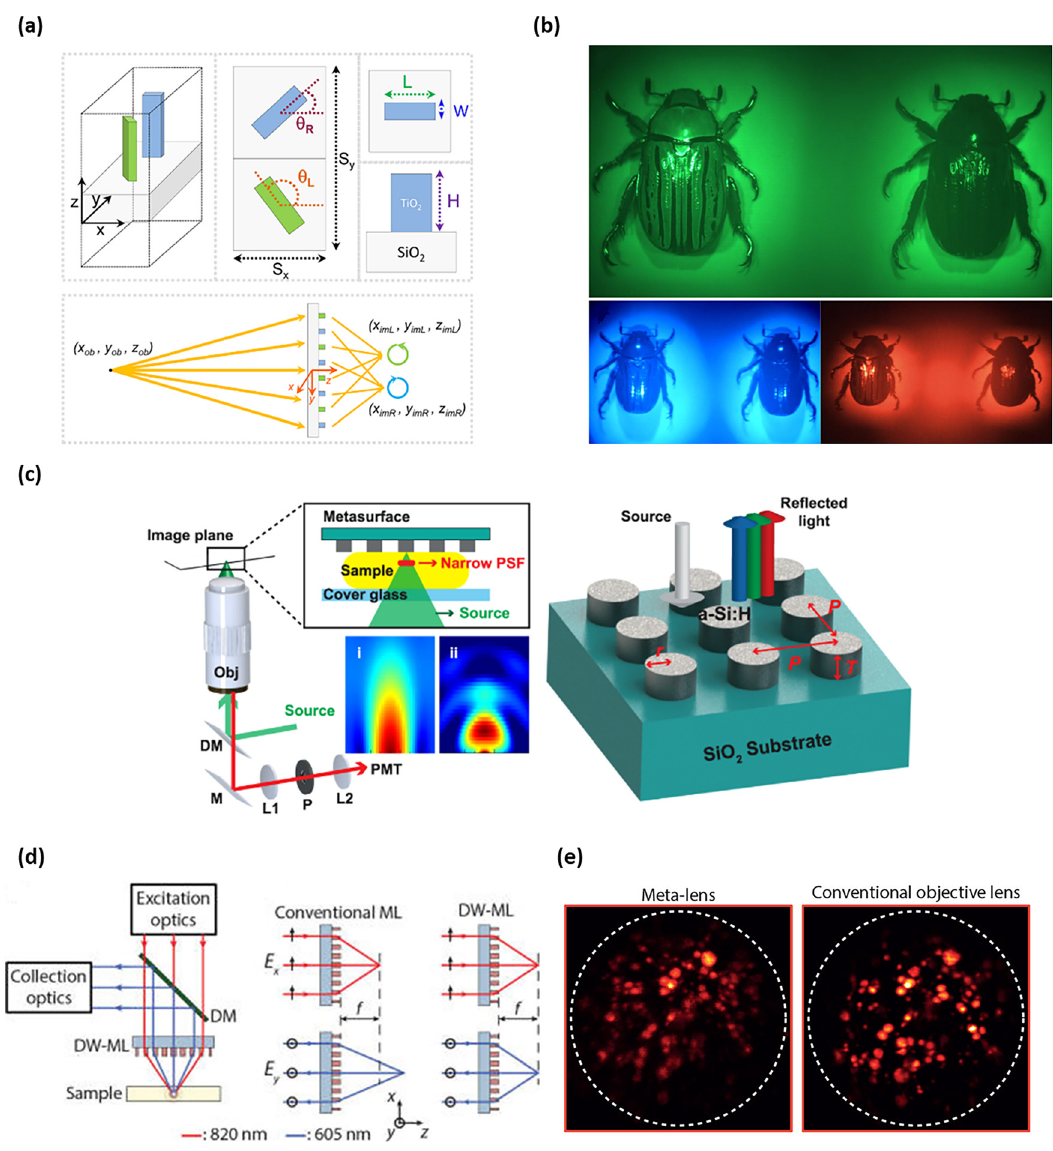
Figure 2: (a) and (b): Chiral imaging; (c) – (e) Fluorescent imaging. (a) (Top row) Perspective view, top view, and side view of the metasurface meta-atoms.(Bottomrow)Schematicshowinganobjectis imagedbya metalenswhichgeneratestwo imagesaccordingto thepolarizationof the light. The green arrow represents left circularly polarized (LCP) light and blue represents right circularly polarized (RCP) light. (b) A beetle sample imaged by LCP light (left) and RCP light (right) showing different features illuminated with a green, blue, and red LED. (a) and (b) Reproduced with permission from Khorasaninejad et al., Nano Lett. 16 , 4595 – 4600 (2016) [96]. Copyright 2016 American Chemical Society. Direct link: https://pubs.acs.org/doi/abs/10.1021/acs.nanolett.6b01897. Further permissions related to the material excerpted should be directed to the ACS. (c) (Left) Schematic of the metasurface-enhanced axial-narrowing imaging system. Obj: objective lens, DM: dichroic mirror, M: mirror, L1 – L2: lenses, P: pinhole. (Right) Schematic of the metasurface consisting of circular-shaped nanodiscs made of a-Si:H. P: period, r: radius, T: thickness. The metasurface re fl ects a narrow range of wavelengths. (c) Reproduced with permission from Lee et al., Opt. Mater. Express 9 , 3248 (2019) [99]. Copyright 2019 Optical Society of America. (d) Schematic showing a two-photon microscope setup with a double-wavelength metalens (DW-ML). Light excitation and collection are from the same position from the sample, i.e. from the same focal plane which is different from a conventional metalens. ML: metalens. (e) Two-photon fl uorescent images of microspheres captured by metalens and conventional objective lens. (d) and (e) Reproduced with permission from Arbabi et al., Nano Lett. 18 , 4943 – 4948 (2018) [101]. Copyright 2018 American Chemical